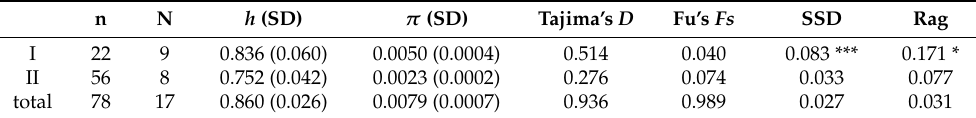
Table 4. Genetic diversity and demographic statistics using mitochondrial data.